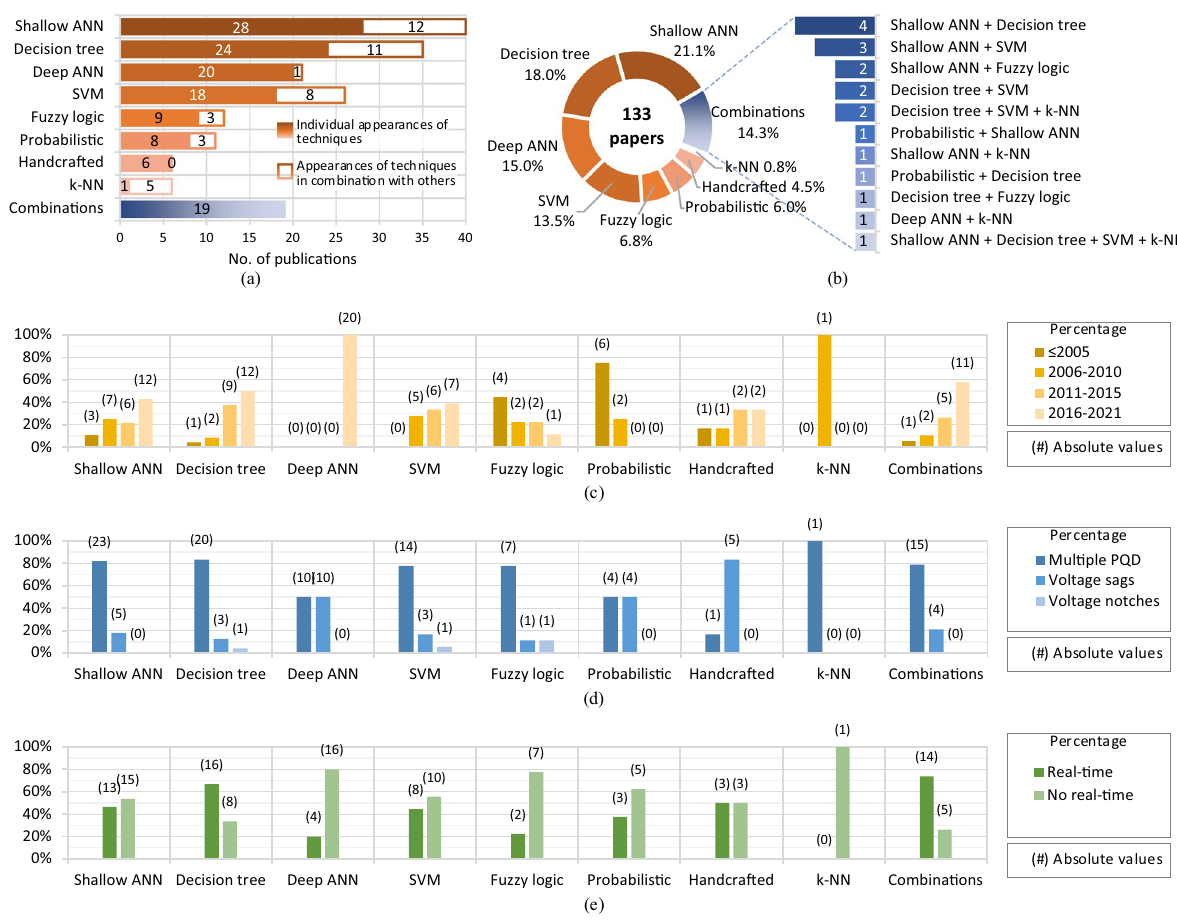
Shallow ANN Decision tree Deep ANN SVM Fig. 12 Distribution of papers in the identified classification techniques. a The number of papers, b percentages and number of papers that use a combination of techniques, c percentages and number of papers from the time perspective, d the type of disturbance perspective, and e the real‑time